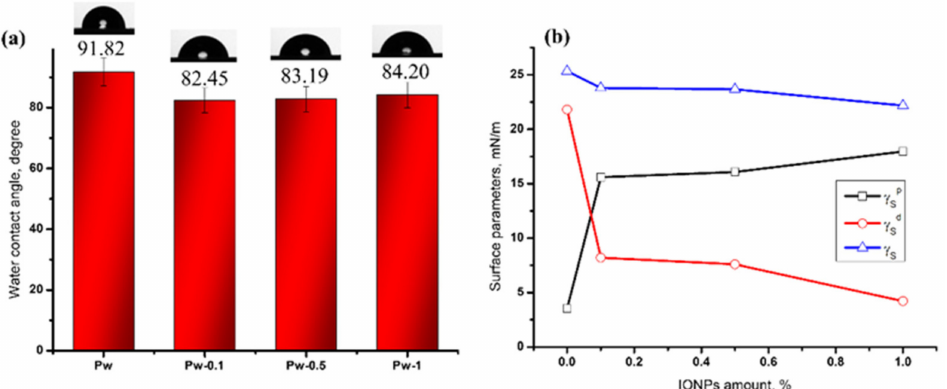
Figure 8. Variation of ( a ) water contact angles and ( b ) surface parameters with IONPs concentration for the PU-based magnetic